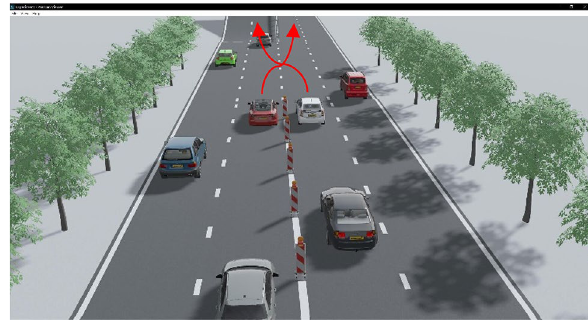
Figure 6. Game scene in complex traffic